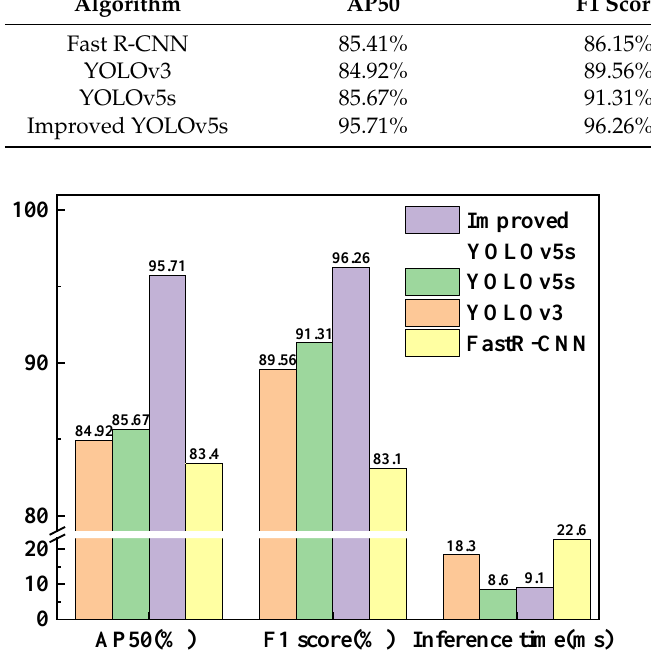
Figure 12. Comparison of evaluation indicators of YOLOv3, YOLOv5s, and improved YOLOv5s models.